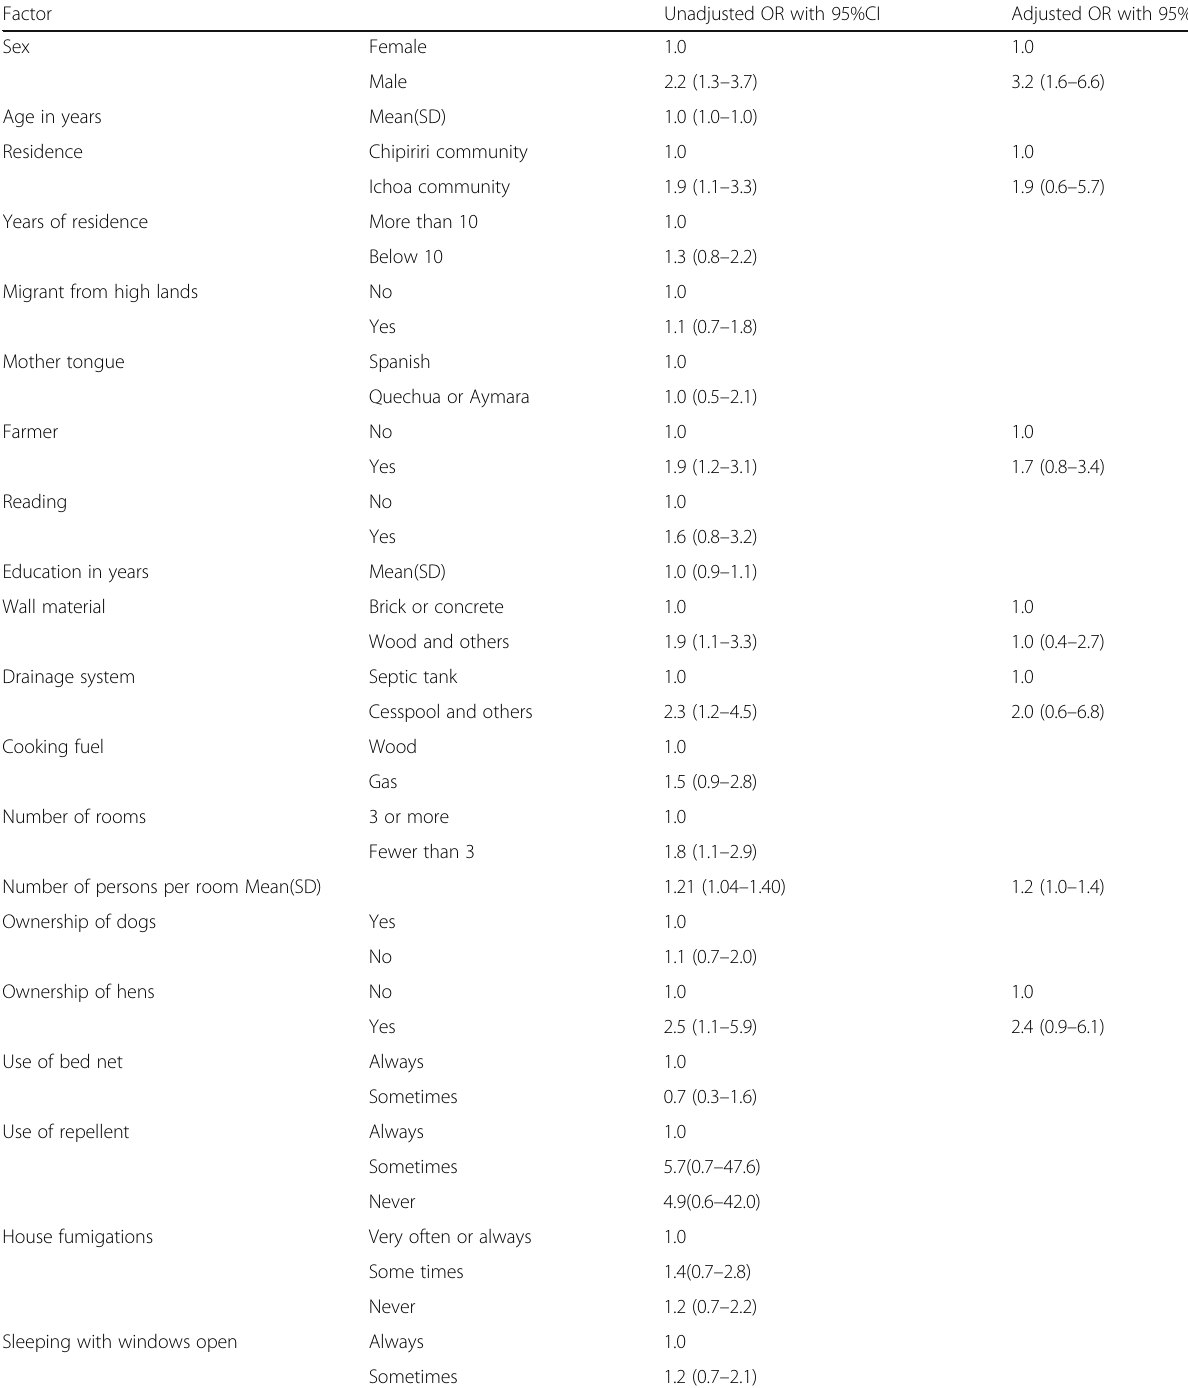
Table 4 Univariate and multivariate analysis of sociodemographic, housing conditions and protective activities associated with